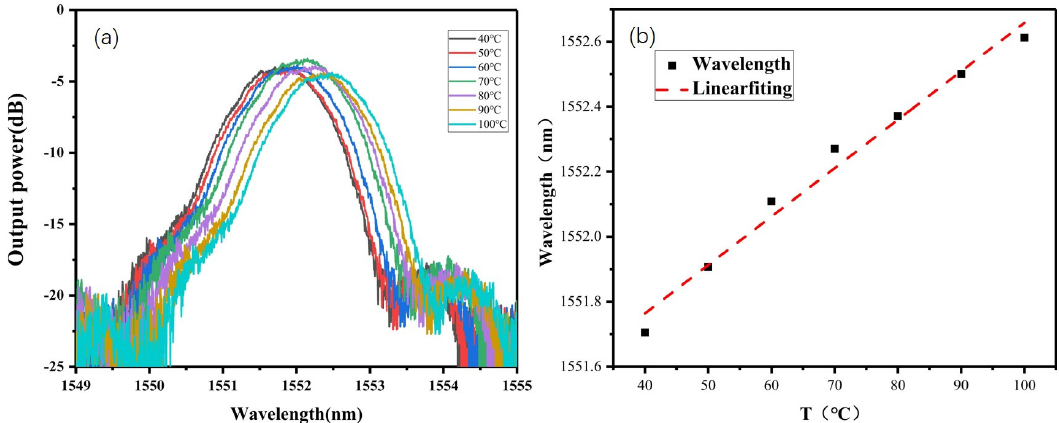
Figure 8. ( a ) the transmission spectra at different temperatures of the fifth output channel (CH5) of the AWG. ( b ) the relationship between the central wavelength of CH5 and temperature of AWG.